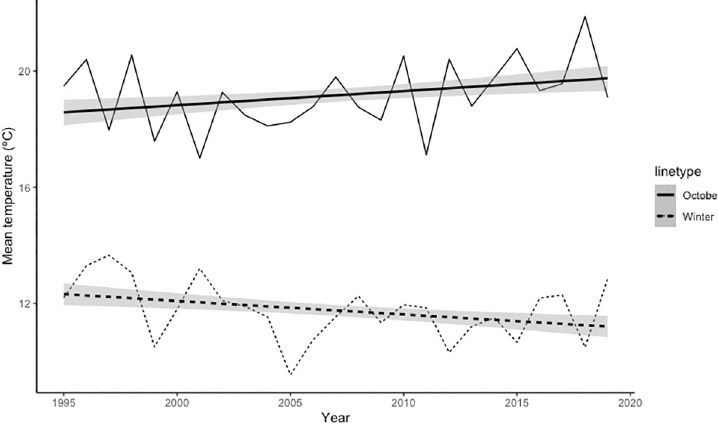
Fig 4. Temporary trend of the mean temperature (C˚) in winter (dashed lines, from December to March) and in October (continuous lines). Straight lines represent the significant linear regressions with ± 2SD.